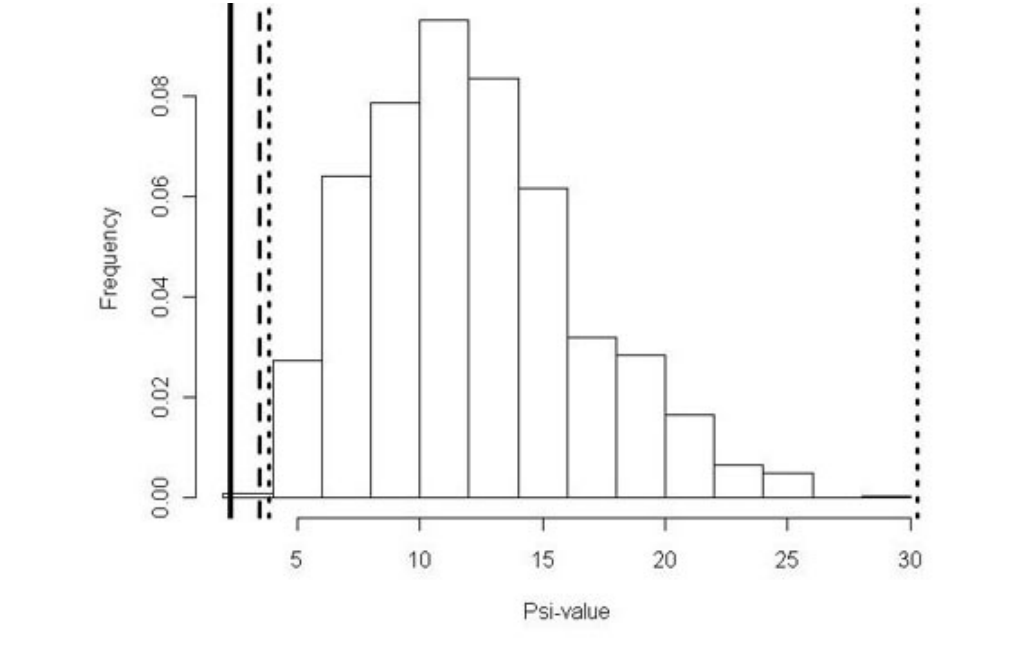
Fig. 6. Distributions of randomization for comparison of scallop distributions of permits and landings for the Washington, D.C. region. Solid line: Psi statistic; Dotted lines: 90% CI; Dashed lines: 95%